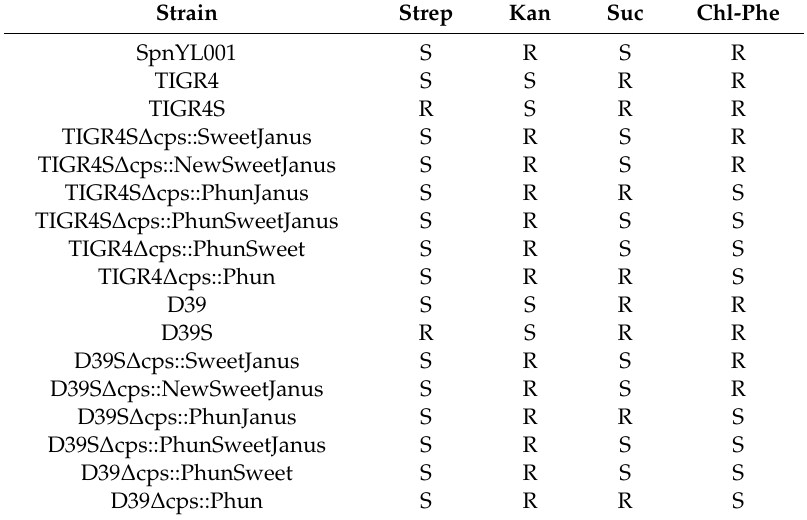
Table 2. Strain resistance (R) and susceptibility (S) to selection agents: 800 µ g / mL streptomycin (Strep), 400 µ g / mL kanamycin (Kan), 10% sucrose (Suc), and 10 mM chlorinated-phenylalanine